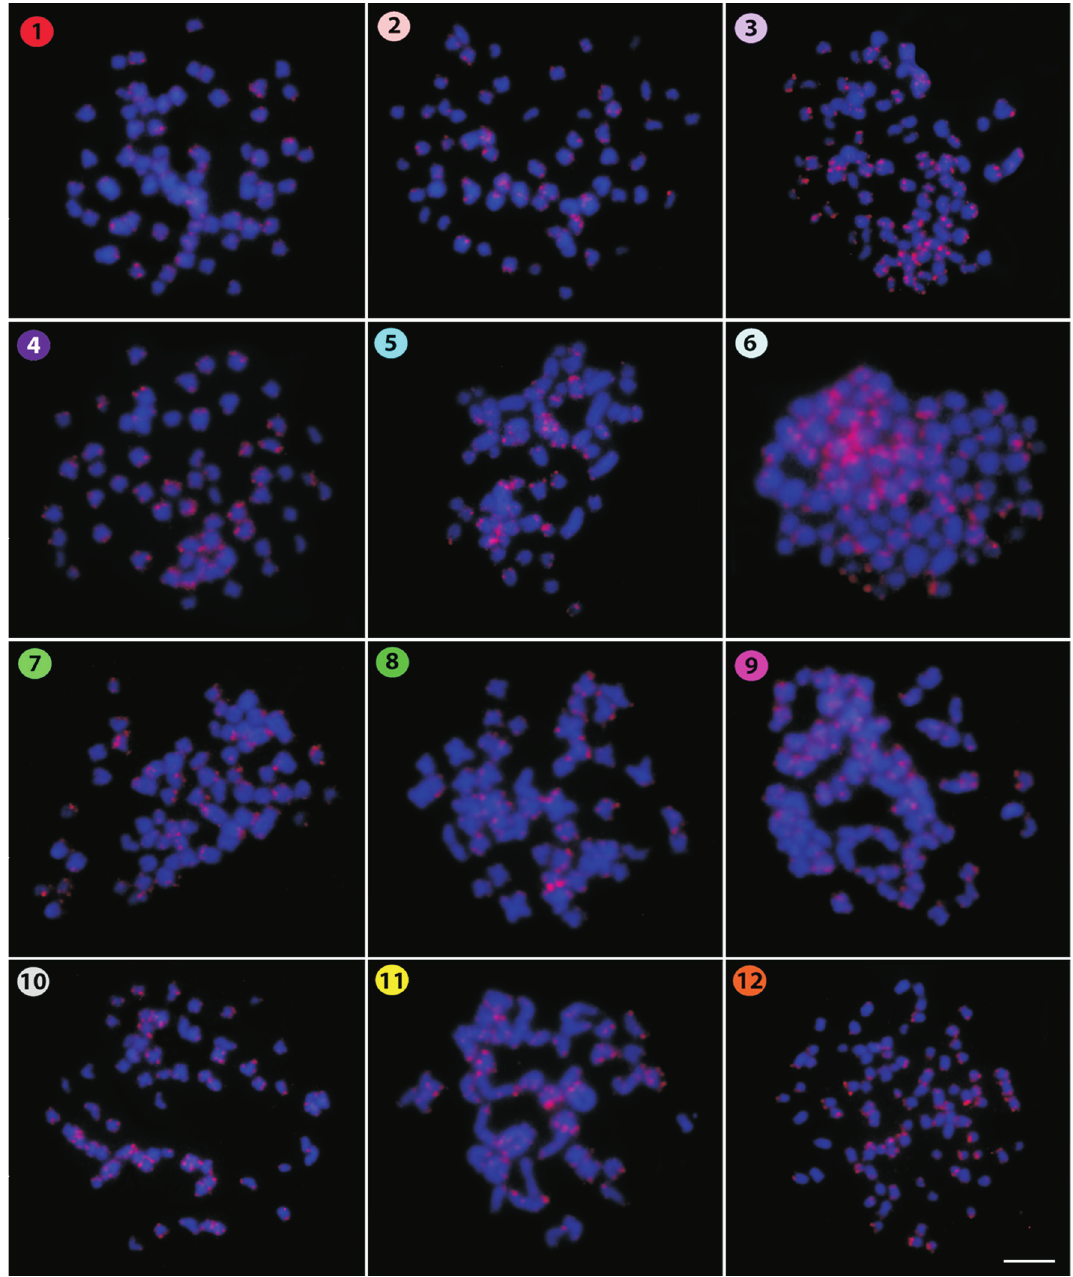
Figure4 -Hybridizationpatternofthe(CAT) 10 microsatelliteprobe(inred)onmetaphaseplatesof Belodontichthystruncates ( 1 ); Kryptopterusbicirrhis ( 2 ); Kryptopterusgeminus ( 3 ); Kryptopteruslimpok ( 4 ); Kryptopterusmacrocephalus ( 5 ); Micronemachevevi ( 6 ); Ompokfumidus ( 7 ); Ompoksiluroides ( 8 ); Phalacronotus apogon ( 9 ); Phalacronotus bleekeri ( 10 ); Silurichthys phaiosoma ( 11 ) and Wallago attu ( 12 ). Scale bar = 5 (cid:2)